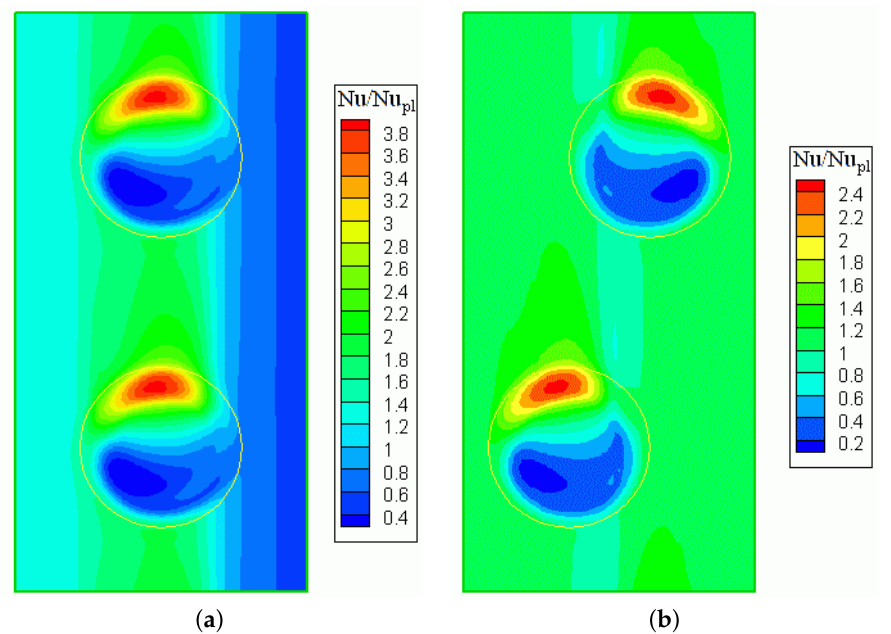
Figure 16. Comparison of the fields of relative Nusselt numbers for reliefs with spherical dimples without displacement ( a ) and with displacement of their centers ( b